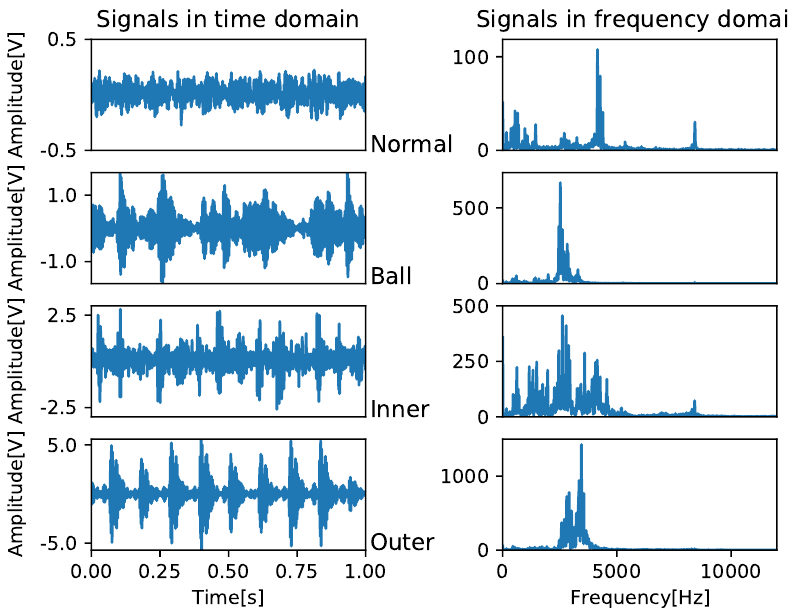
Figure 2. Exemplary of some vibration signals in T and F domains for the four class